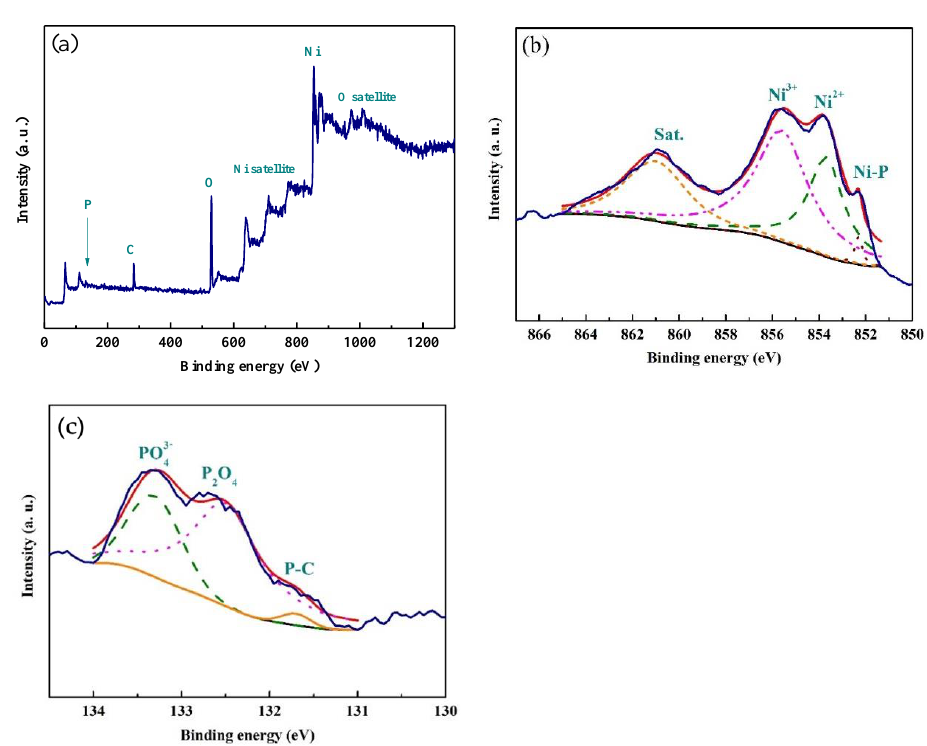
Figure 2. XPS spectra of the P-NiO in ( a ) the whole region, ( b ) the Ni 2p 3/2 region and ( c ) the P 2p region.